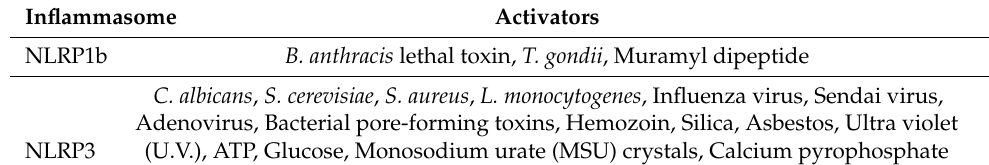
Table 2. Activators of Different